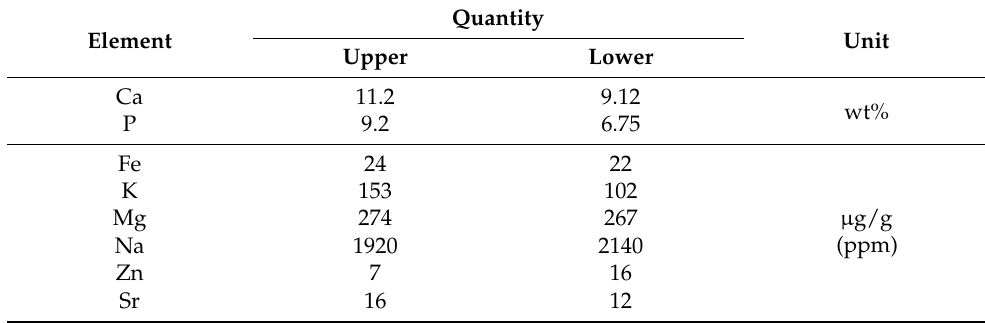
Table 1. ICP-AES for quantitative analysis of elements.